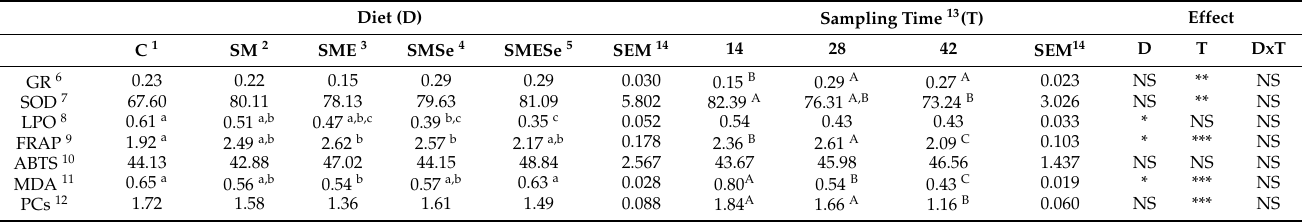
Table 3. Enzyme activities (Units/mL), total antioxidant capacity, and oxidative stress biomarkers in the milk of goats fed the five diets at the three sampling